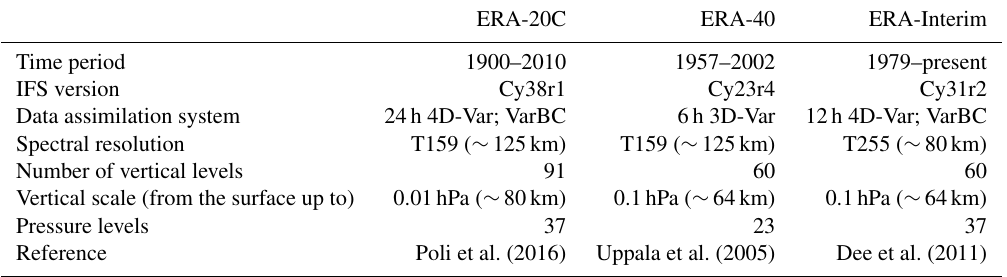
Table 1. Characteristics of ERA-20C, ERA-40 and ERA-Interim reanalyses. 4D-Var (3D-Var): four-dimensional (three-dimensional) varia- tional analysis; VarBC: variational bias correction of surface pressure observations.